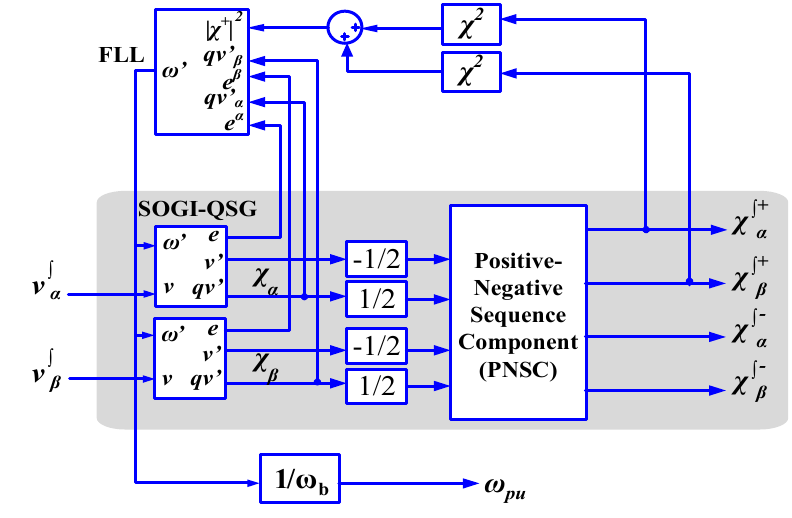
Figure 7. Positive & negative sequence of virtual flux.